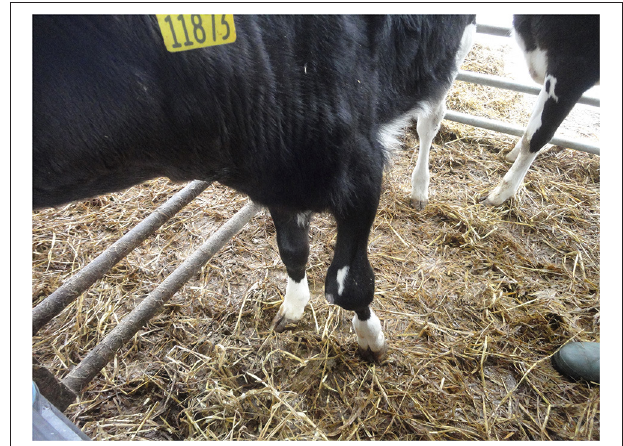
FIGURE 12 | Purulent peritonitis in the abdomen of a calf.